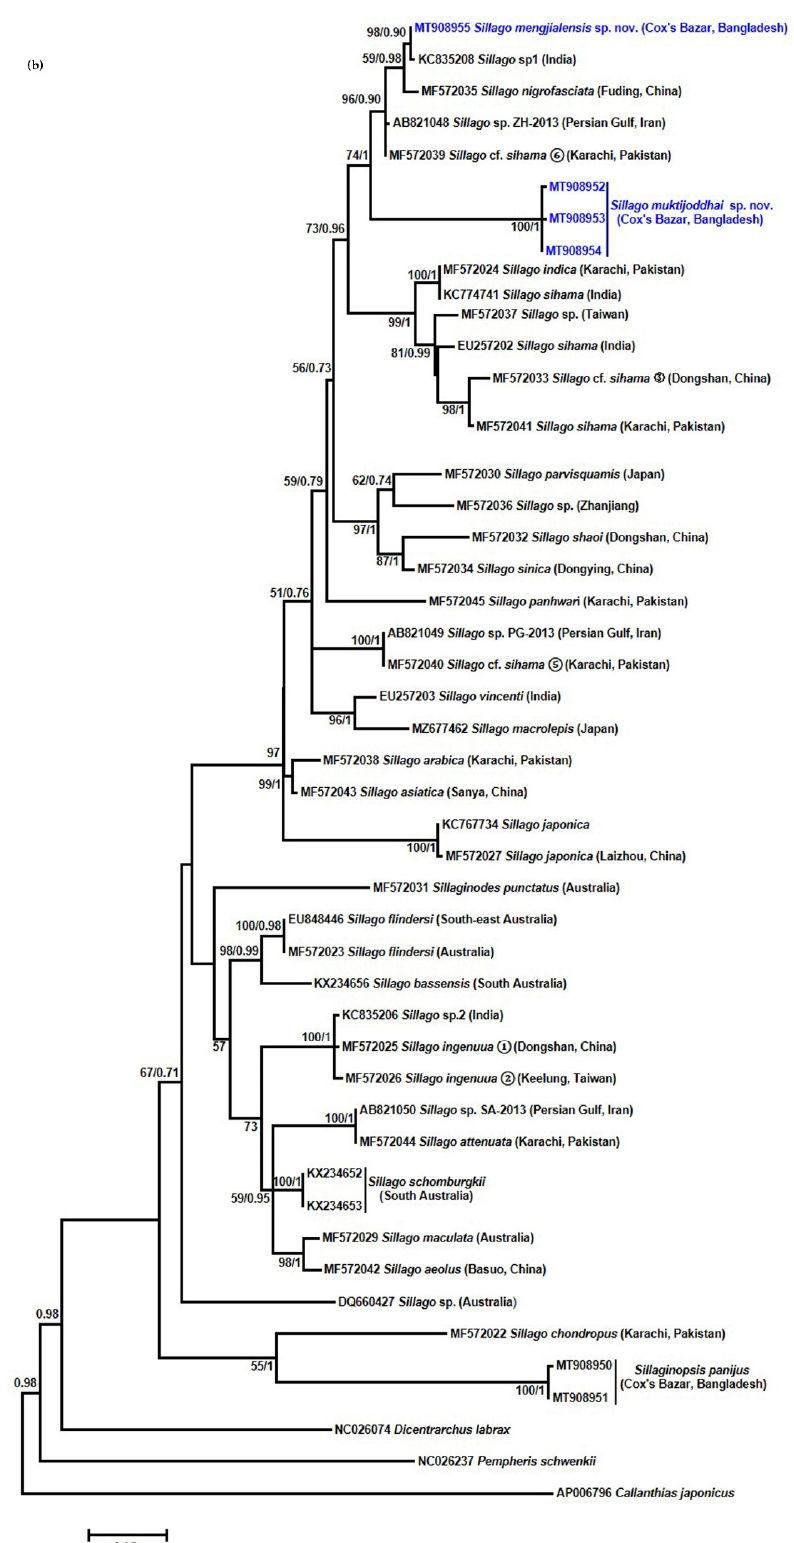
Figure 4. Phylogenetic tree using the maximum likelihood analysis and Bayesian phylogenetic analysis method for the species of Sillaginidae. ( a ) COI gene sequences of 42 species; ( b ) 16S rRNA gene sequences of 32 species. The maximum likelihood topology was similar to the result of the Bayesian analysis. Bootstrap support values/Bayesian posterior probabilities are displayed at branch nodes. Three species of the suborder Percoidei, Callanthias japonicas , Dicentrarchus labrax, and Pempheris schwenkii , were selected as outgroup